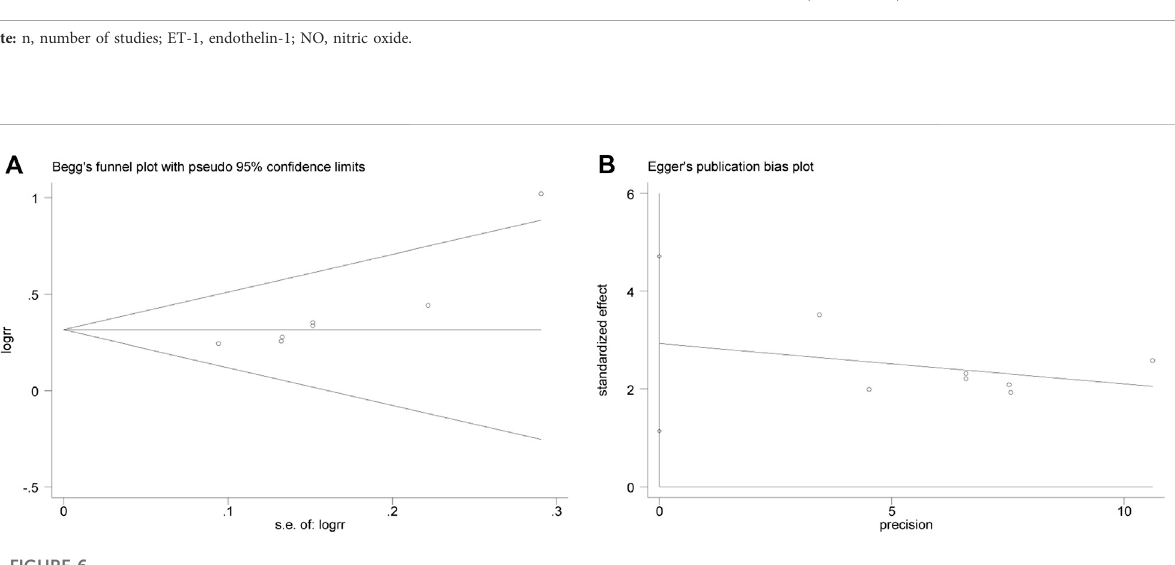
FIGURE 6 Begg (A) and Egger (B) test for ef fi cacy on angina